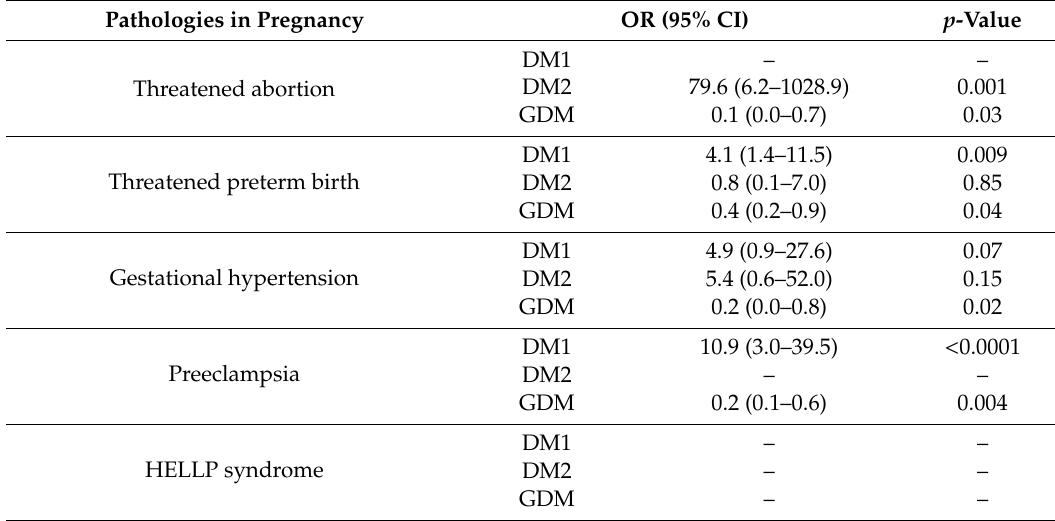
Table 2. Maternal-fetal outcomes and the various types of diabetes. Pathologies in